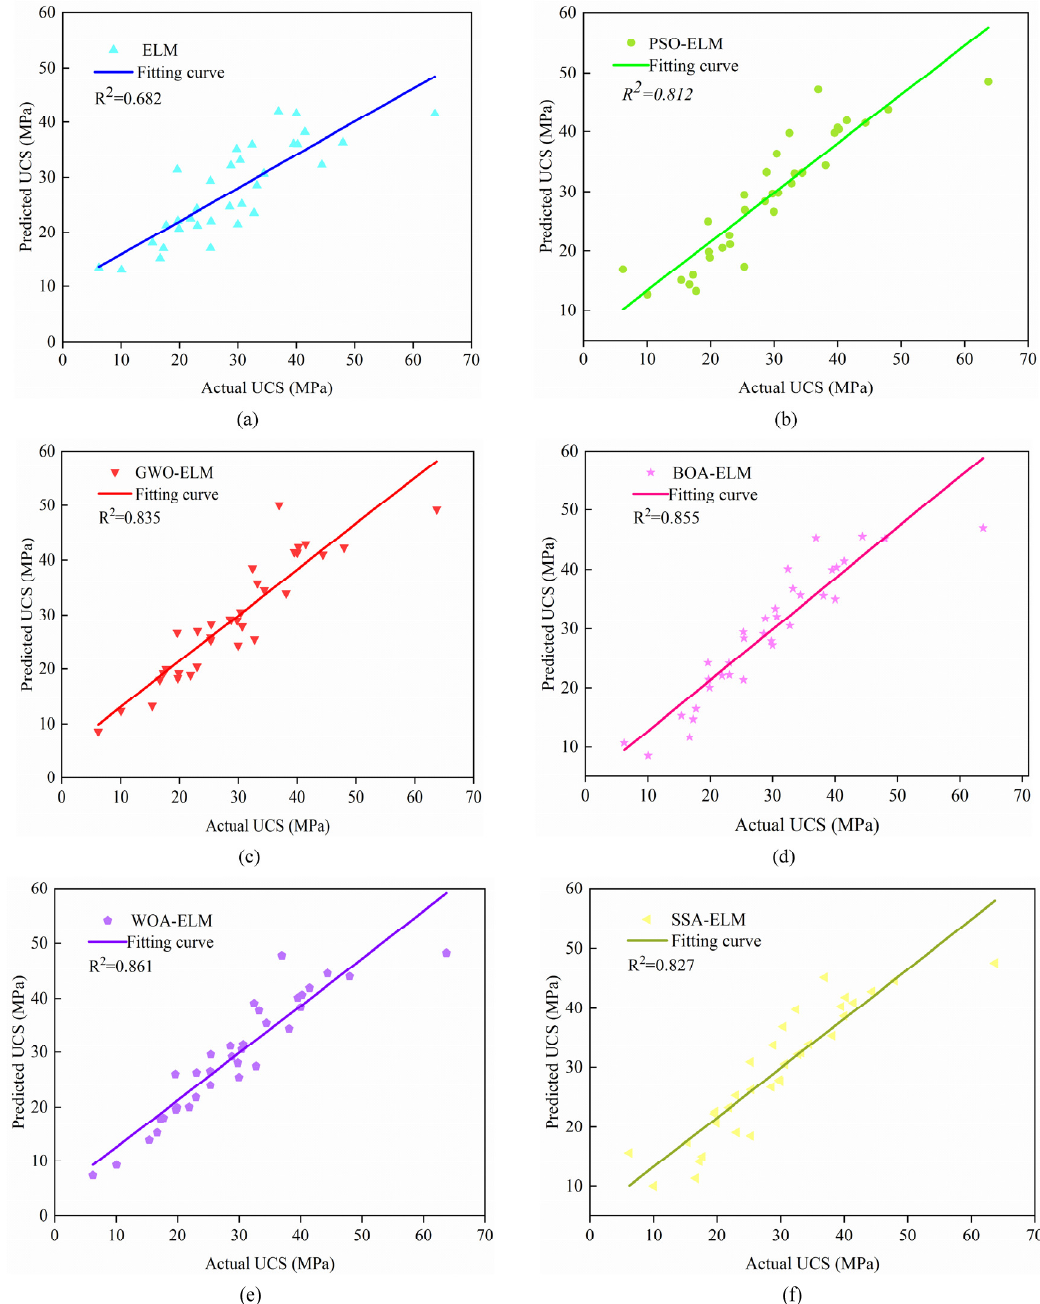
Figure 8. UCS results utilizing a single ELM and hybrid ELM models optimized by PSO, GWO, WOA, BOA, and SSA. ( a ) R 2 of measured and predicted values of UCS using ELM model; ( b ) R 2 of measured and predicted values of UCS using PSO-ELM model; ( c ) R 2 of measured and predicted values of UCS using GWO-ELM model; ( d ) R 2 of measured and predicted values of UCS using BOA-ELM model; ( e ) R 2 of measured and predicted values of UCS using WOA-ELM model; ( f ) R 2 of measured and predicted values of UCS using SSA-ELM model.